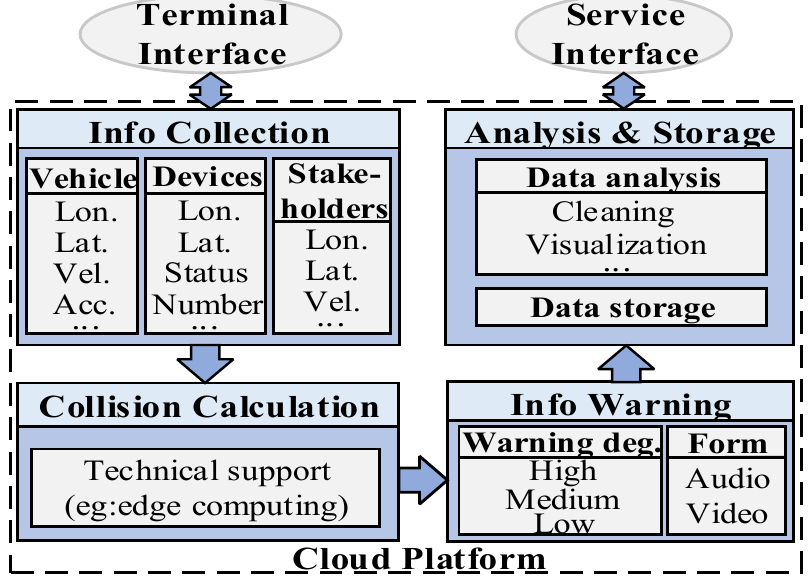
Figure 6. Cloud platform structure.